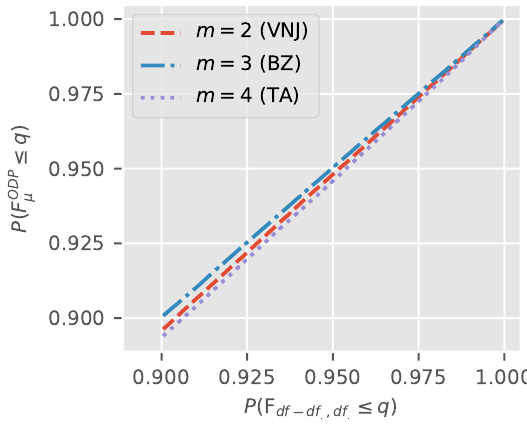
Figure 8. Distribution of F ODP µ conditional on non-rejection of a 5% Bartlett